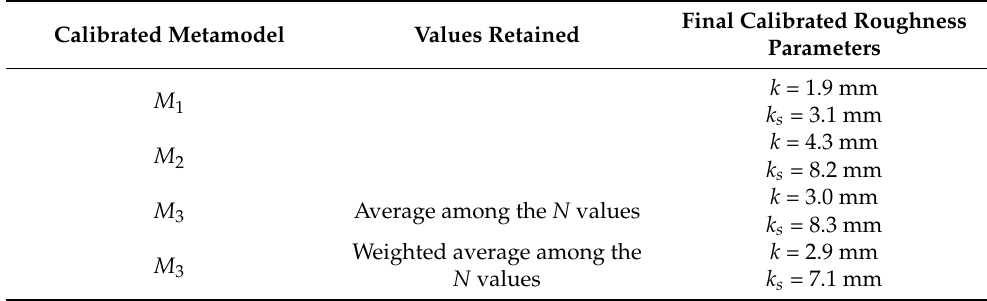
Table 8. Calibrated roughness parameters (genetic algorithm).